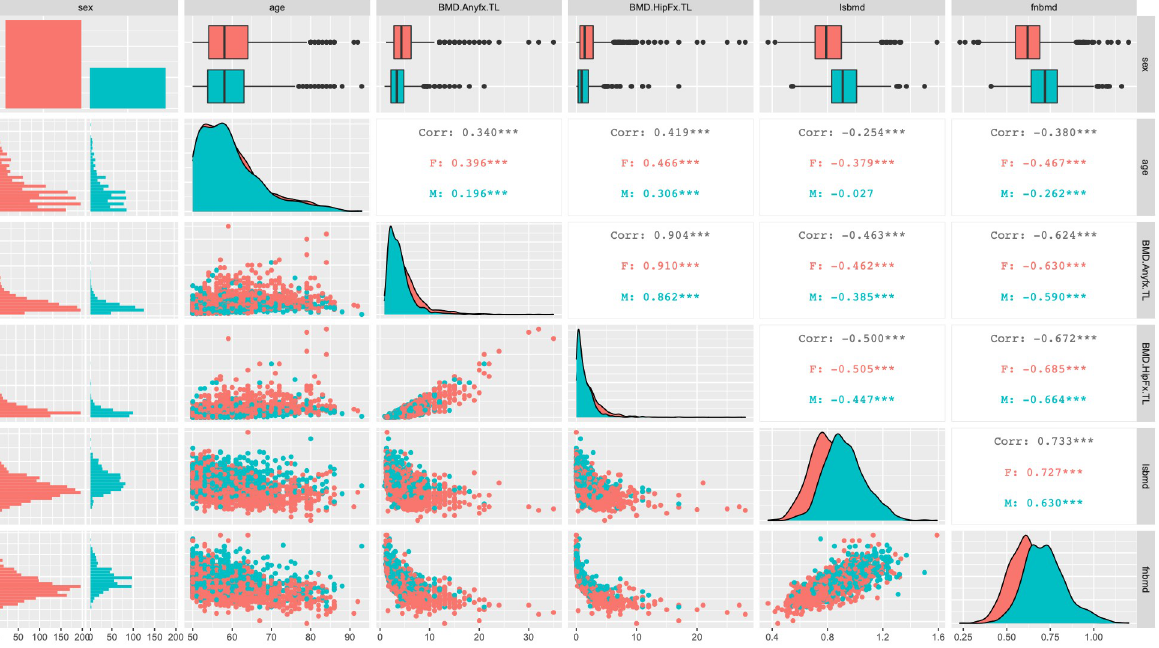
Fig 1. Correlation between age, 10-year risks of fracture ("BMD.Anyfx.TL" and "BMD.Hipfx.TL"), femoral neck BMD ("fnbmd") and lumbar spine BMD ("lsbmd") stratified by gender. The diagonal figures show the histogram of the distribution of each variable. The upper diagonal numbers show the linear correlation coefficient between two variables. The lower diagonal figures visualize the correlation between two